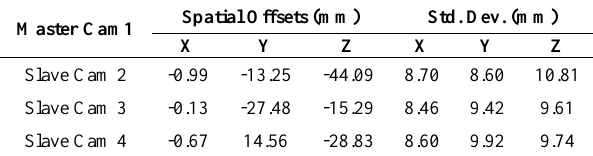
Table 1. Relative spatial offsets.